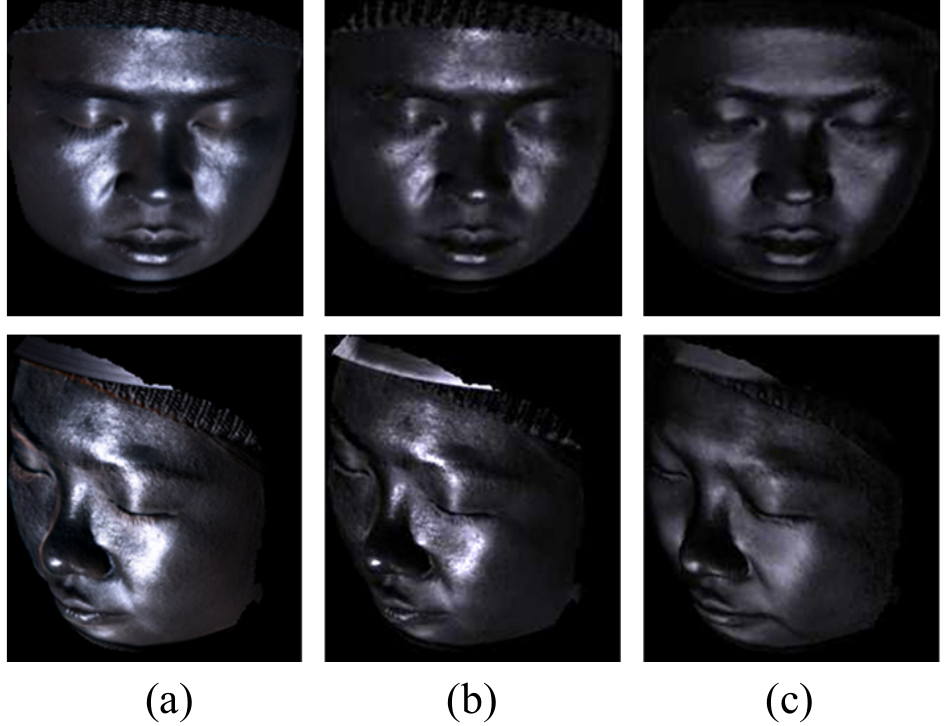
Figure 3. Examples of specular component. ( a ) Ground truth. Results by our method under ( b ) dichromatic model and ( c ) mirror reflection